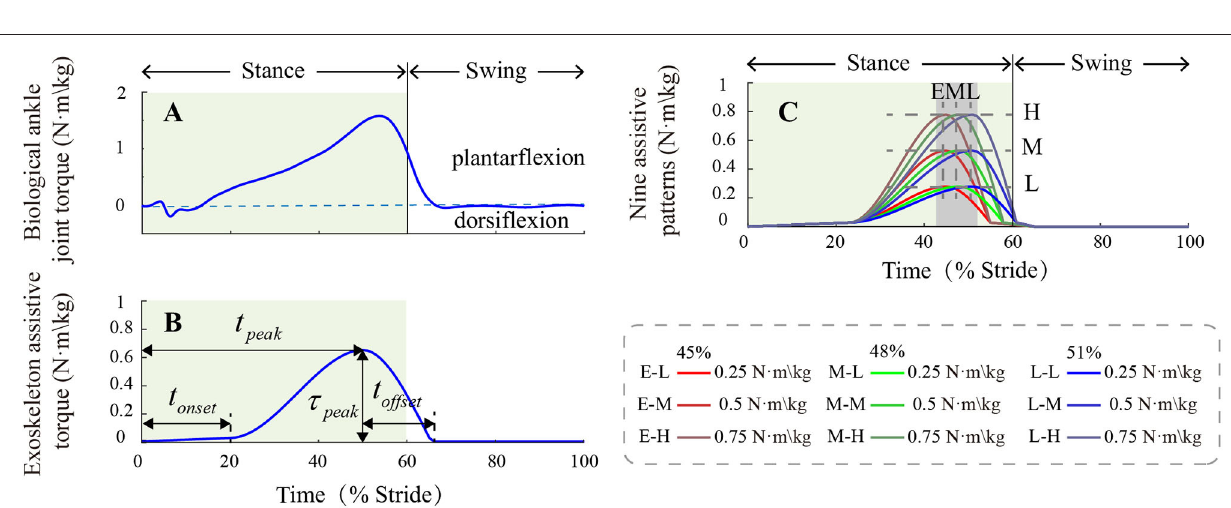
the wearer. Offset timing t off represented the time from